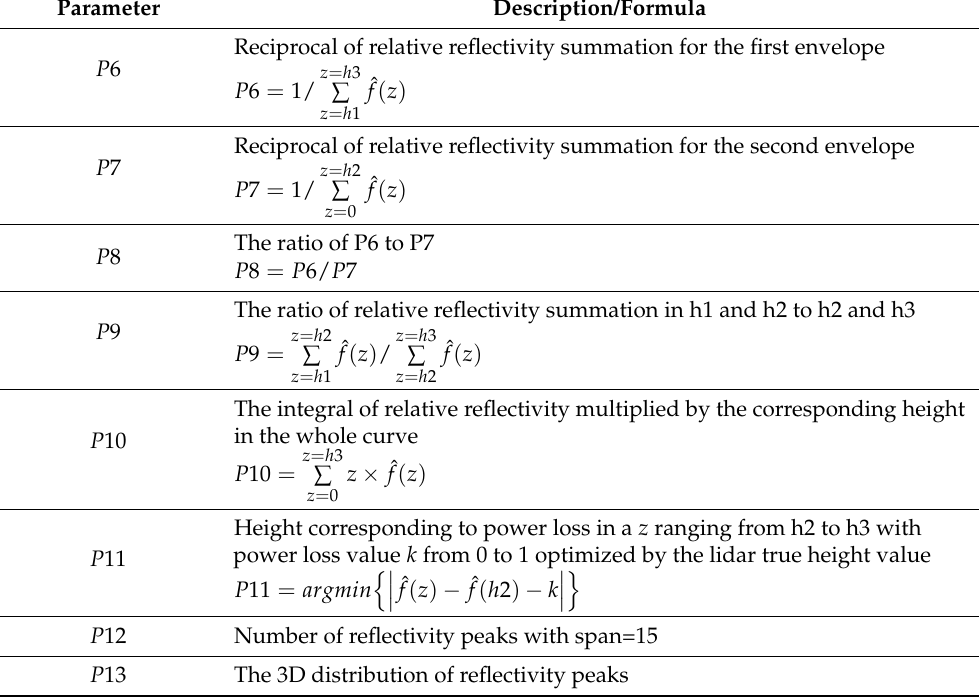
Table 2. Cont. Parameter